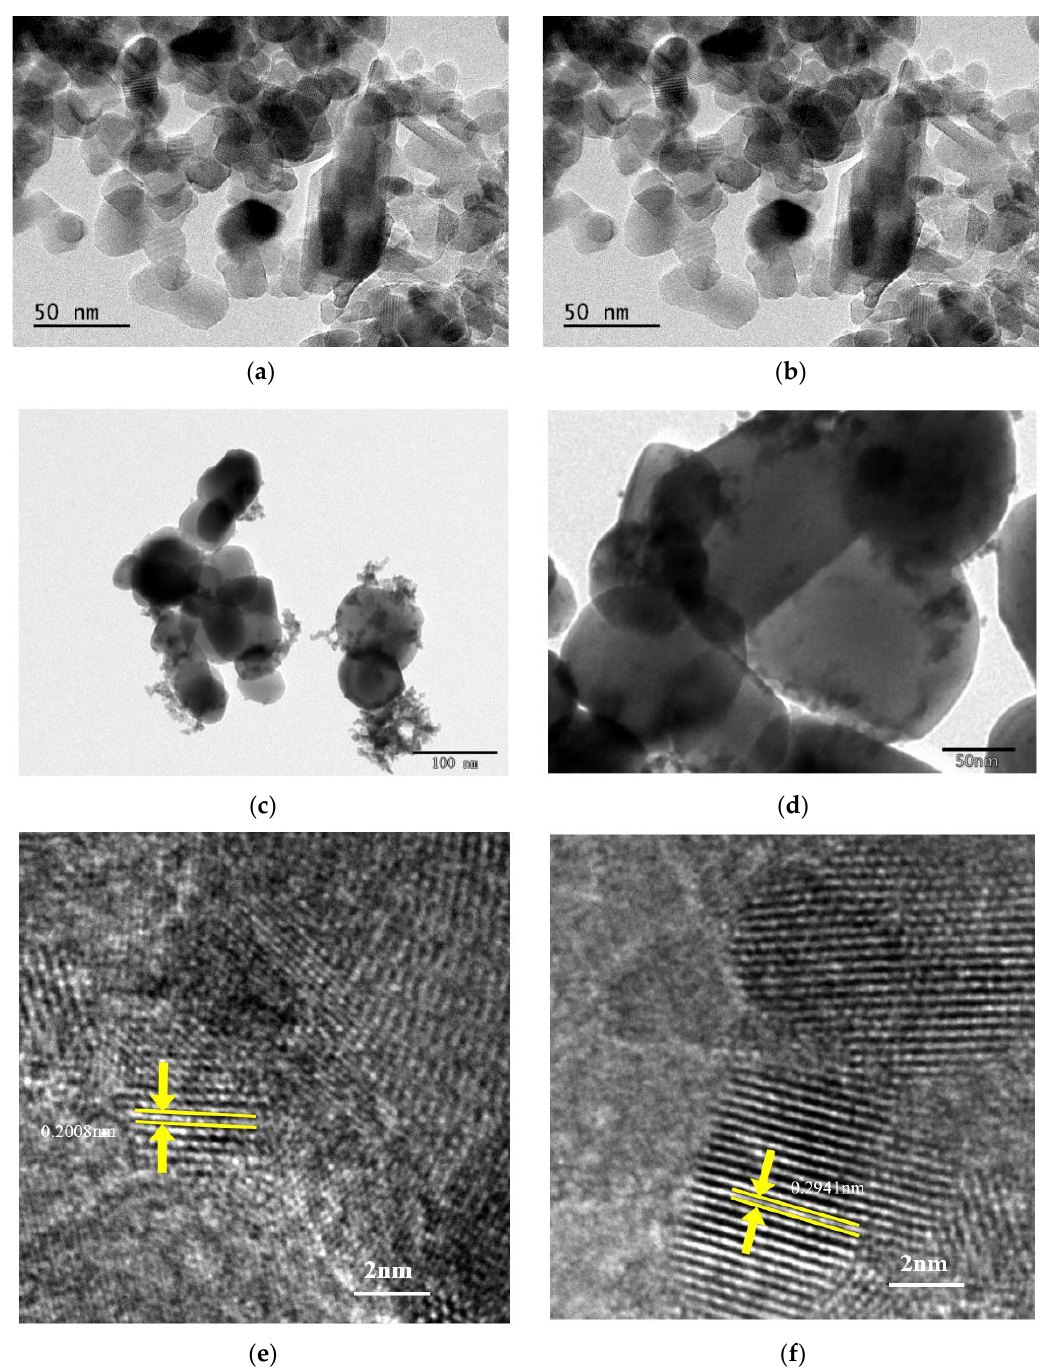
Figure 3. TEM images of Al 2 O 3 /TiO 2 ( a , b ); TEM images of Mn-Ce(4:1)/Al 2 O 3 /TiO 2 ( c , d ); HRTEM images of Mn-Ce(4:1)/Al 2 O 3 /TiO 2 ( e , f ).